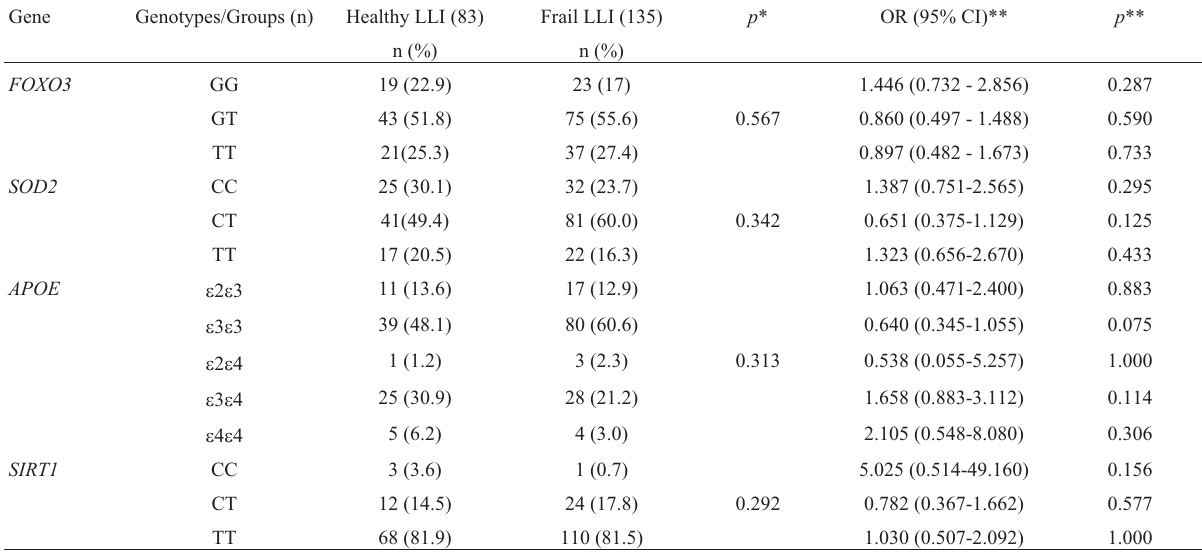
Table 4 - Distribution of FOXO3, SOD2, APOE and SIRT1 genotypes between healthy and frailty status of the long-lived individuals. Gene Genotypes/Groups